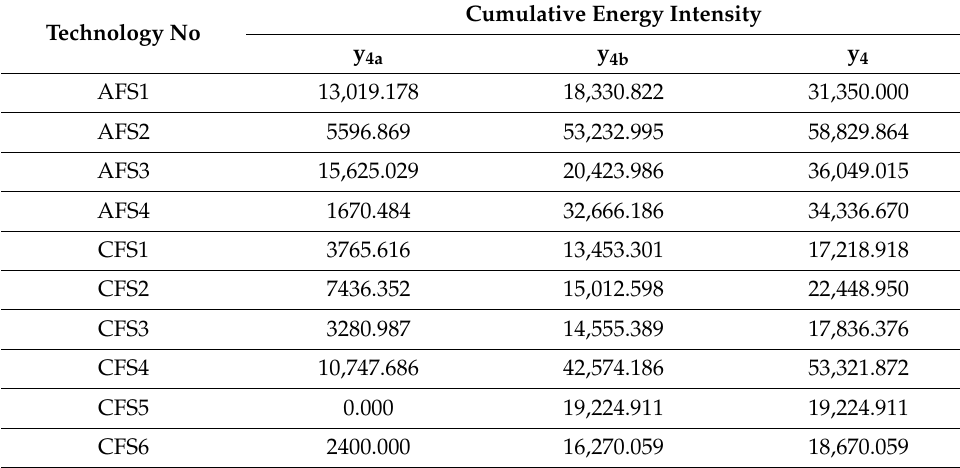
Table 8. Cumulative energy intensities for machinery and